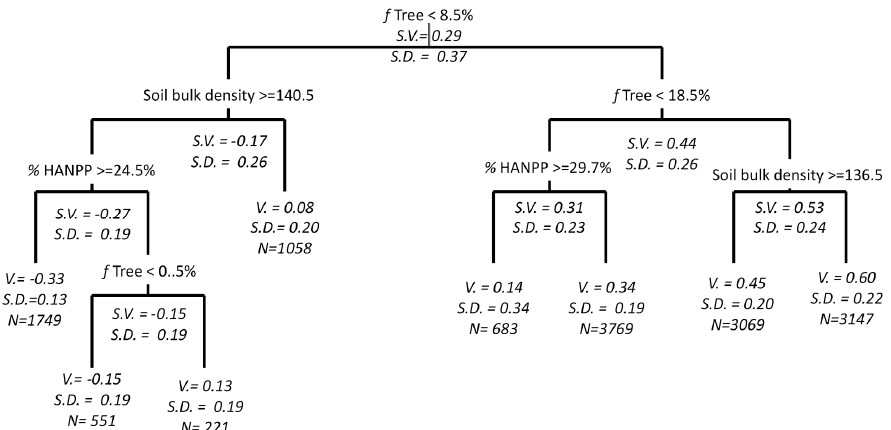
Figure 9. Pruned regression tree showing the hierarchical relations of RESTREND to %HANPP and to soil and land cover properties. Regression tree r 2 = 0.65 and RMSE = 0.21; f Tree—fraction tree cover; %HANPP—percentage human appropriation of NPP; S.V. —node split value; S.D. —standard